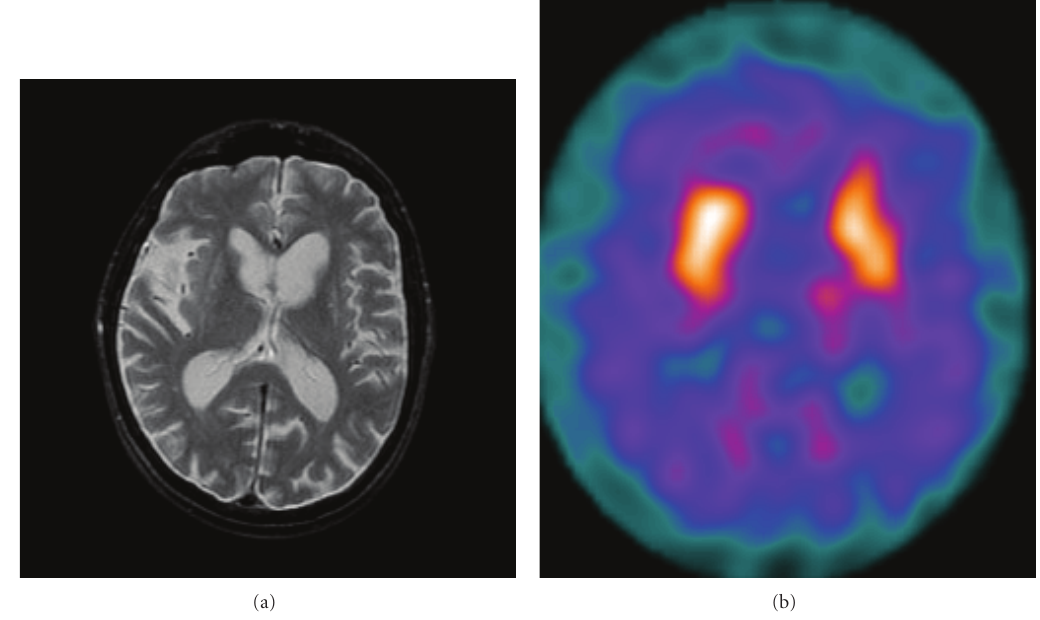
Figure 1: (a) Brain MRI showing severe atrophy of both caudate nuclei and moderate cortical atrophy. (b) SPECT imaging of the striatal dopamine transporter (DAT) with [ 123 I]- β -CIT revealing a symmetric impairment of uptake in the caudate (mean 0.78, normal range 1.7–3.3) and putamen (mean 0.61, normal range